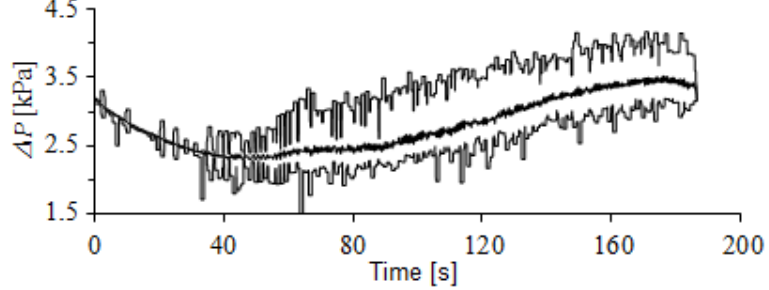
Figure 2. Maximum, minimum, and average values of the pressure drop oscillations during a single pressure drop oscillation ( PDO ) cycle for P = 46 W and G = 159 kg/m 2 s.